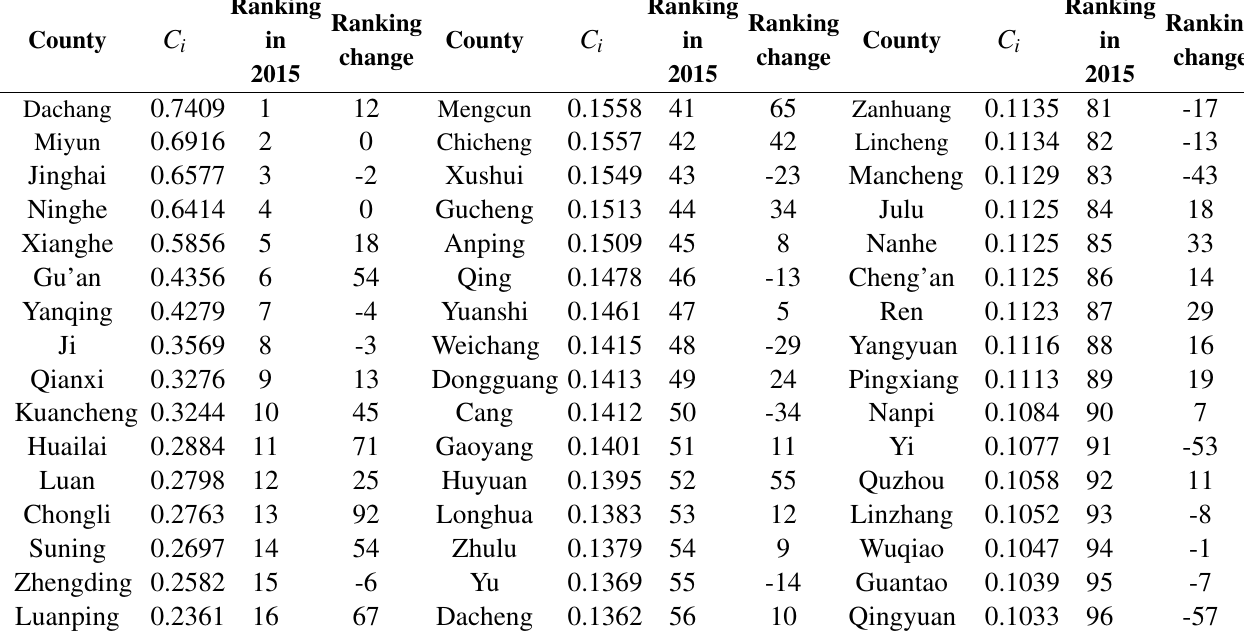
Table 3 Scores and ranking of the 118 counties in the Beijing-Tianjin-Hebei